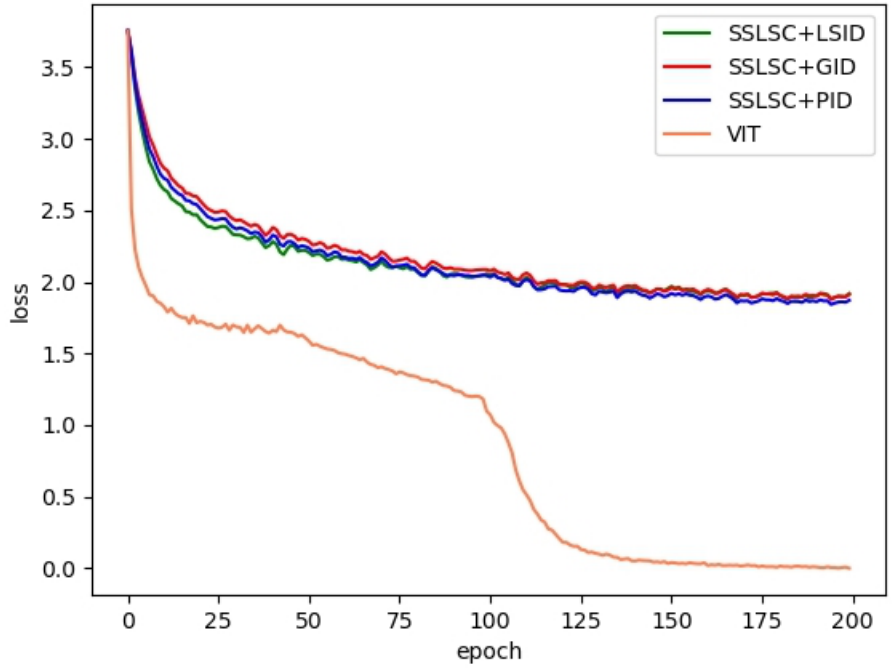
Figure 7. Train loss of our proposed method on NWPU dataset.